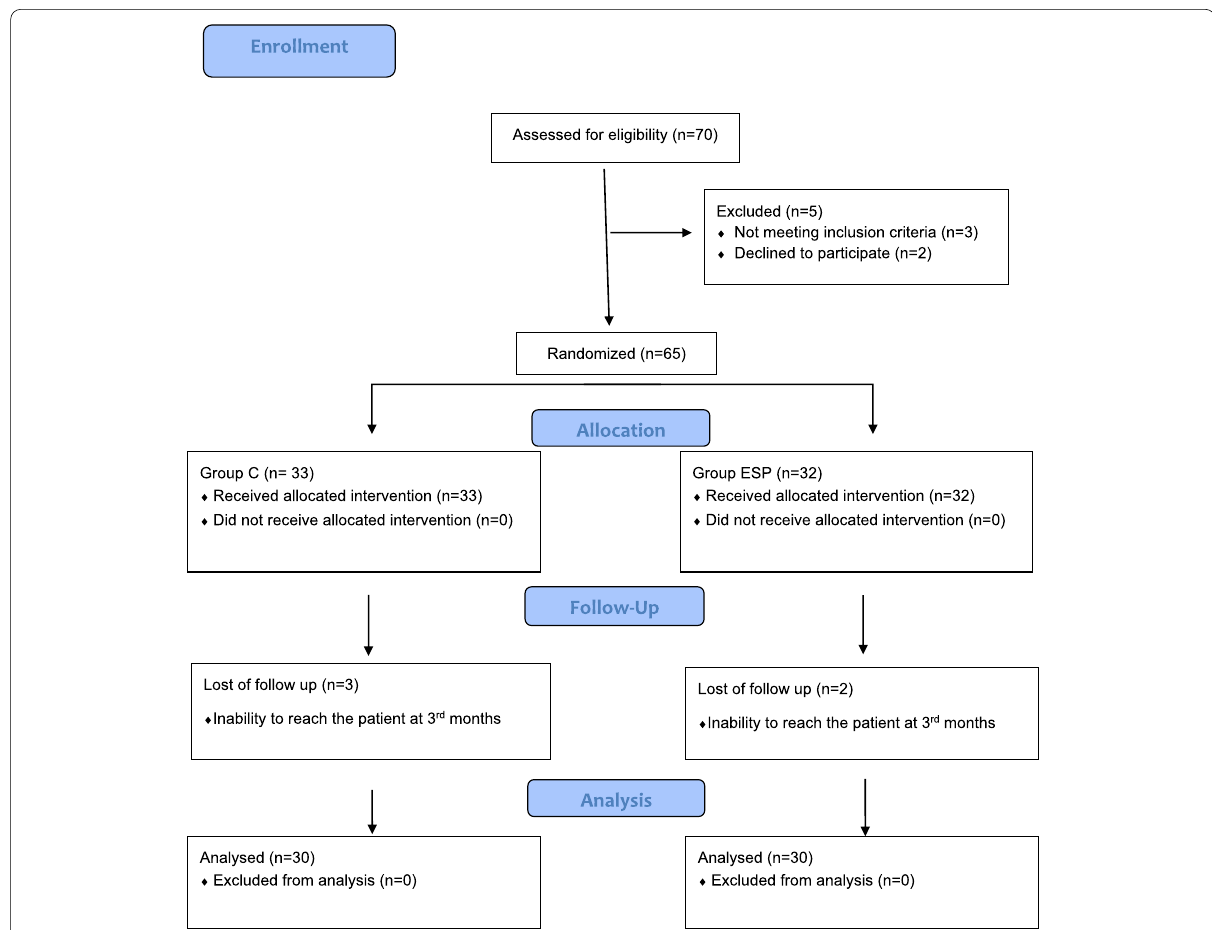
Fig. 1 Flow diagram showing the distribution of patient data. Abbreviations: ESP, erector spinae